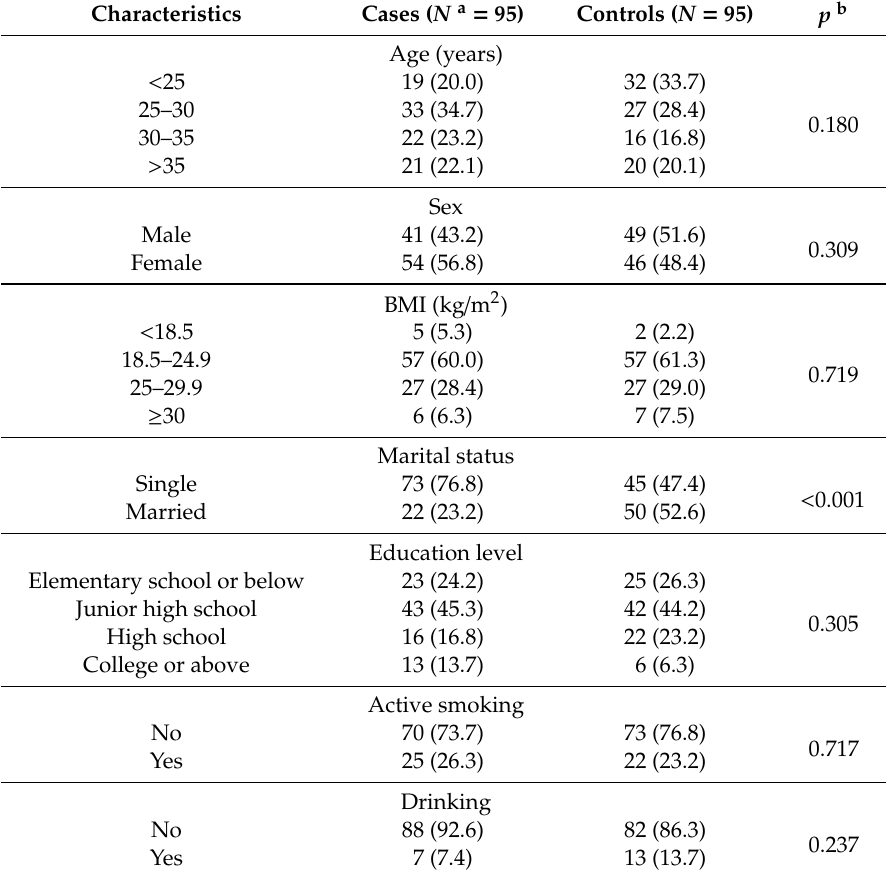
Table1. Distributionofthecharacteristicsofschizophrenicpatients(cases)andhealthysubjects(controls).